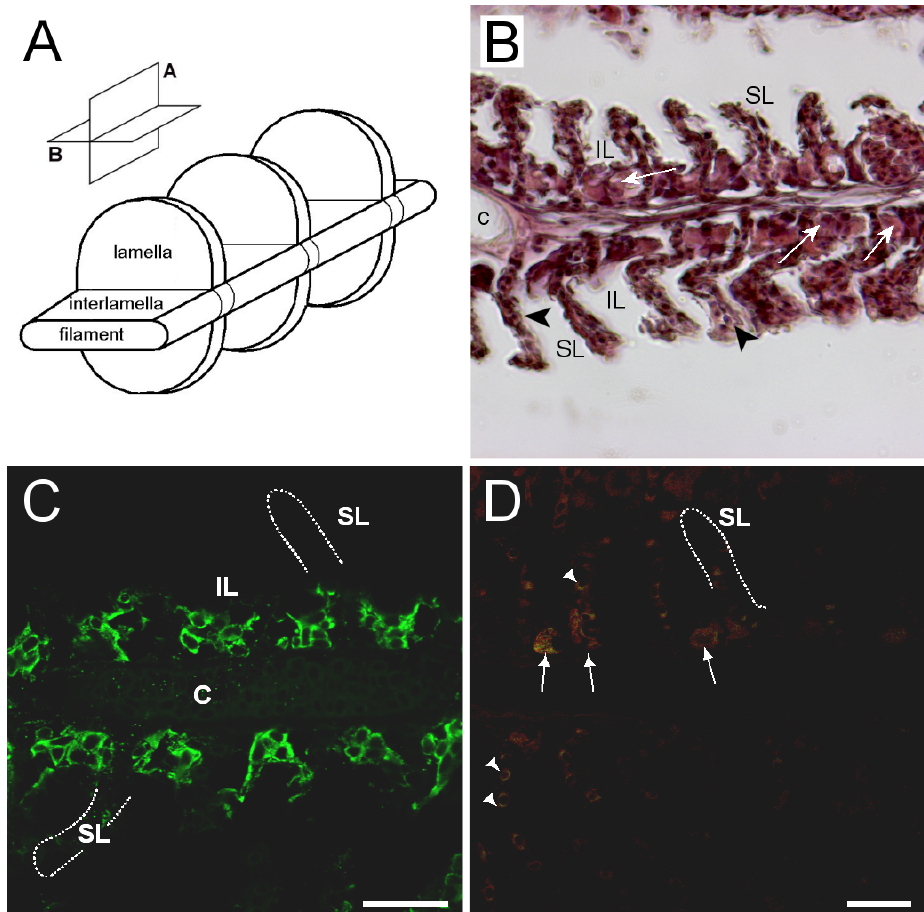
Figure 9. ( A ) three-dimensional (3D) diagram of gill filament morphology with orientation planes; ( B ) bright field image of sagittal gill section (plane A) of hematoxylin–eosin-stained gill filament; ( C ) representative confocal image of sagittal section from FW medaka gills showing immunoreactivity against medaka AQP3 (green)); and ( D ) negative control sagittal gill section incubated without primary antibodies. Abbreviations: SL = secondary lamella; IL = interlamellar space; and c = cartilage. Arrows point to ionocytes, and arrowheads point to red blood cells showing weak autofluorescence in ( D ). The outlines drawn in ( C ) and ( D ) show the contour of secondary lamellae for orientation. Scale bars = 20 µ